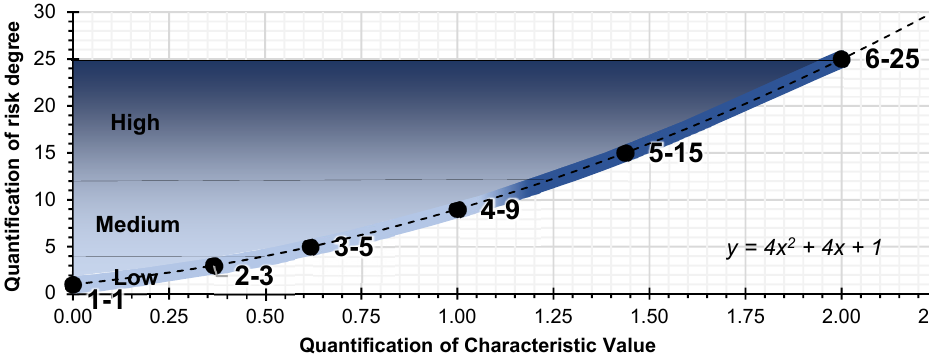
Figure 1. Characteristic values graphic: relative risk, border risk and exposure risk.